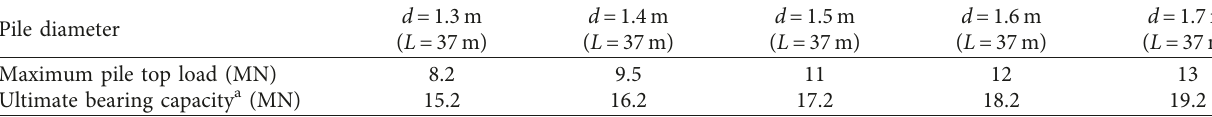
Table 8: Maximum load on top of piles with different diameters (results of scheme 1) and the corresponding ultimate bearing capacity.